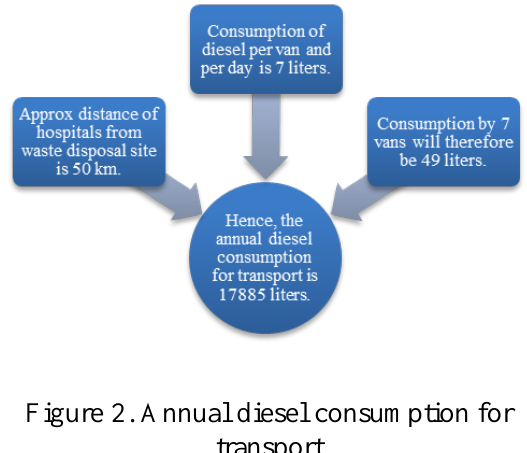
Figure 2. Annual diesel consumption